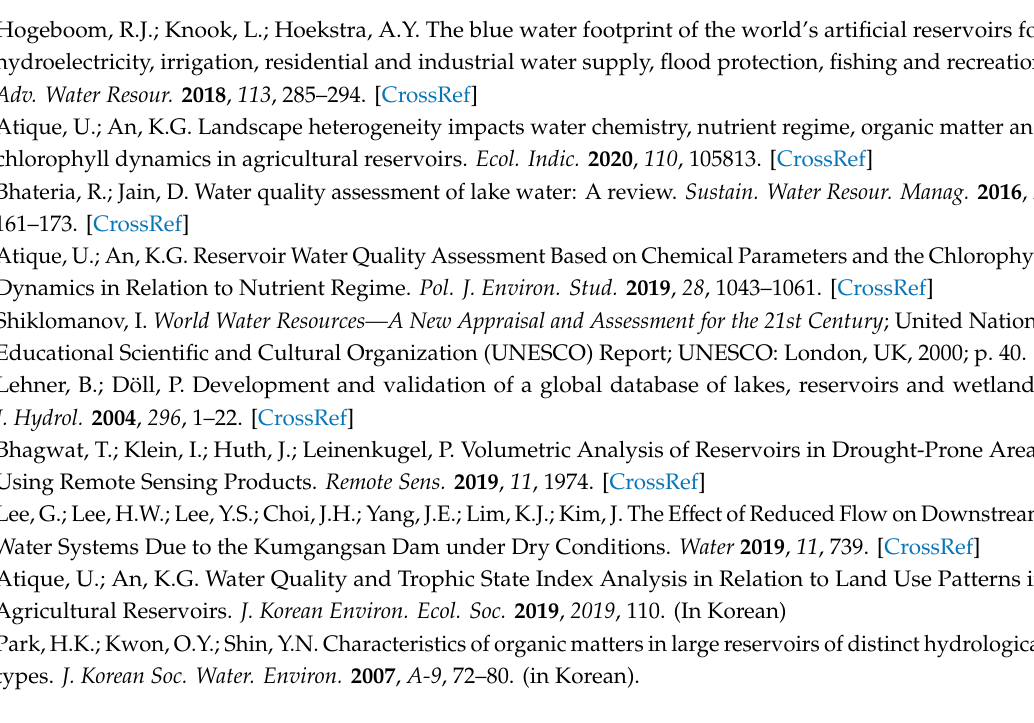
Table S1: Detailed location of study sites in the Soyang